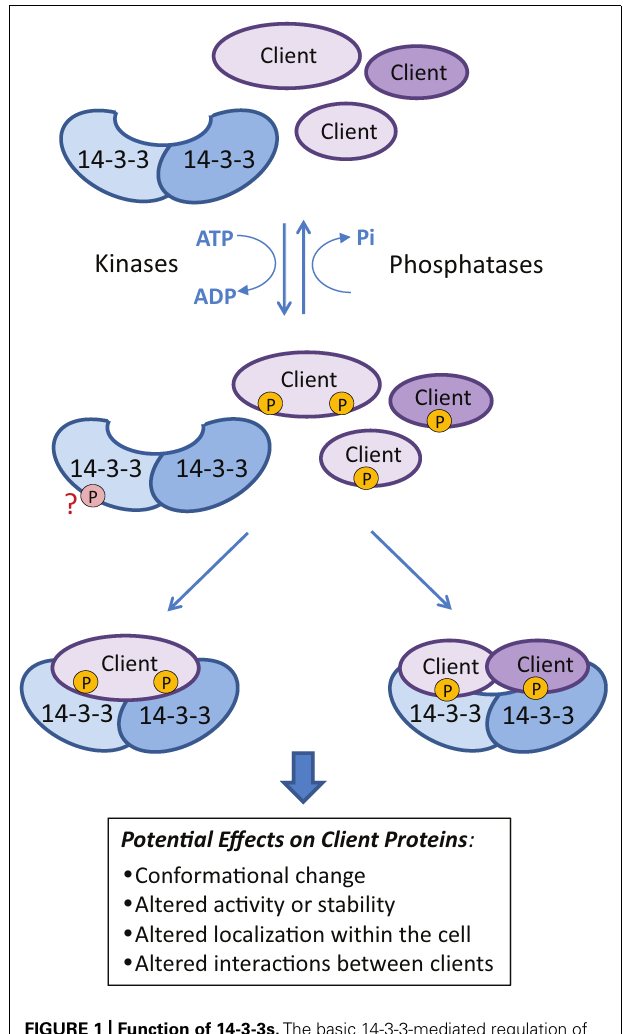
FIGURE 1 | Function of 14-3-3s. The basic 14-3-3-mediated regulation of client activity is a two-step process whereby the target protein is first phosphorylated by a specific kinase.This creates a recognition site for the binding of dimeric 14-3-3 proteins, which can have a number of different effects on client activity. Each 14-3-3 monomer can bind to different sites on the same client protein or each can bind different client proteins. 14-3-3s may themselves be phosphorylated (as indicated by “?”) although the effects on client binding are not well